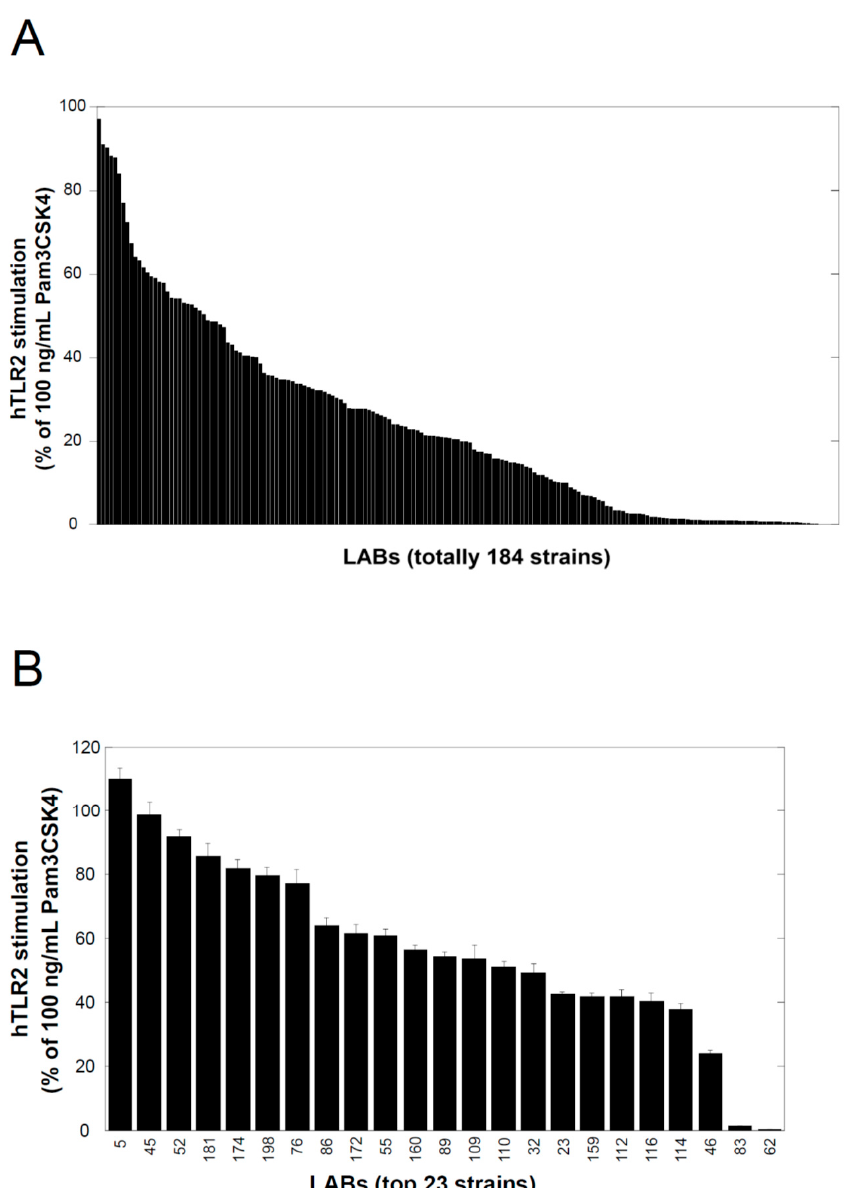
Figure 1. TLR2-stimulating activity of culture supernatants of lactic acid bacteria determined using the human TLR2 reporter cells HEK293, as described in the Materials and Methods section. ( A ) Effects of 400-fold dilutions of MRS ferments of 184 lactic acid bacterial strains isolated from traditional fermented foods (n = 1). ( B ) Effects of 25-fold dilutions of the ferments of the top 23 strains in Figure 1A. In this experiment, a hot water extract of asparagus (edible stem) supplemented with 3% cow skimmed milk was used as the culture medium (n = 3; mean with S.D.). The number at the bottom of the figure is the arbitrary numbering of the strains. In both figures, each bar represents TLR2-stimulating activity relative to that of a 100 ng/mL solution of Pam3CSK4, arranged according to activity (stronger to weaker from left to